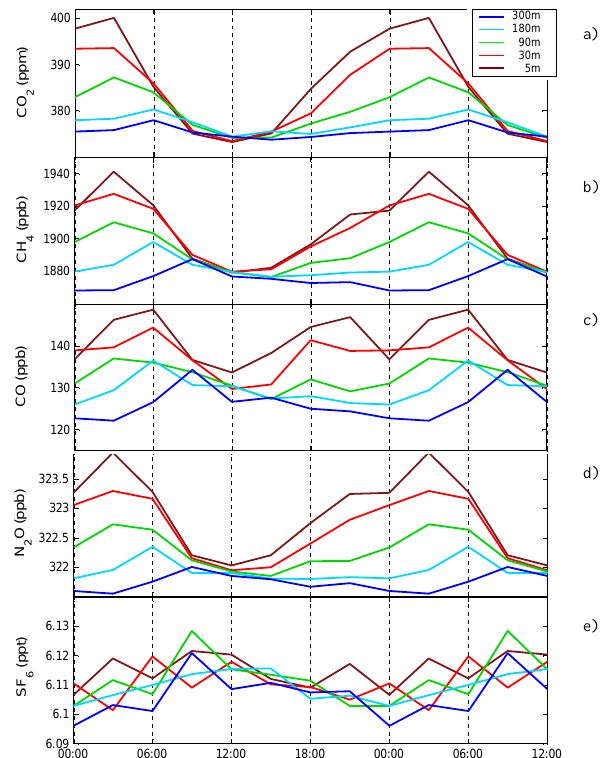
322322.5323323.5 Fig. 8. Average diurnal variation of CO 2 , CH 4 , CO, N 2 O and SF 6 for the period June–September 2006. X-axis represents GMT time (=local time-2 h). The colours represent different sampling heights. The averages for 3-h bins are calculated using a robust method, the lowest and the highest 5% of the data being dismissed. The first half of day was repeated for visual